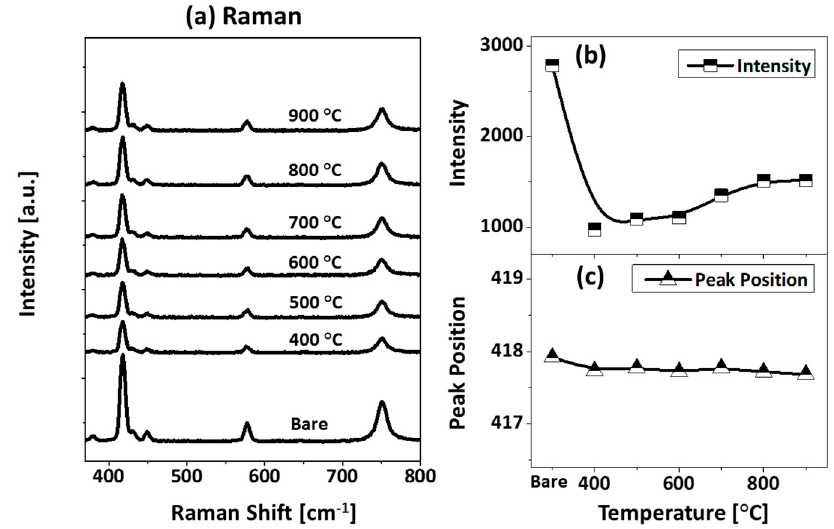
Figure A10. ( a ) Raman spectra of samples shown in Figure A8. ( b , c ) Summary plots of intensity and peak position of Raman band A 1g . Table A1. Summary of roughness (Rq), surface area ratio (SAR) of the samples with various deposition amount, composition, and annealing temperature.